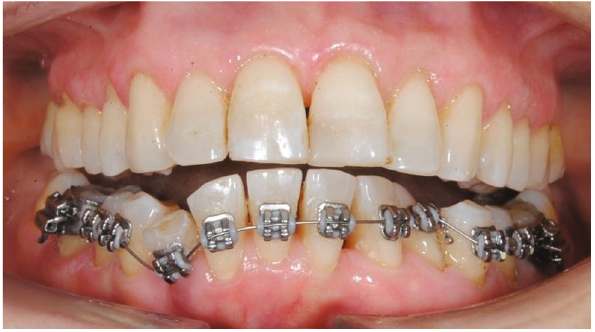
Figure 3: 0.012-in NiTi